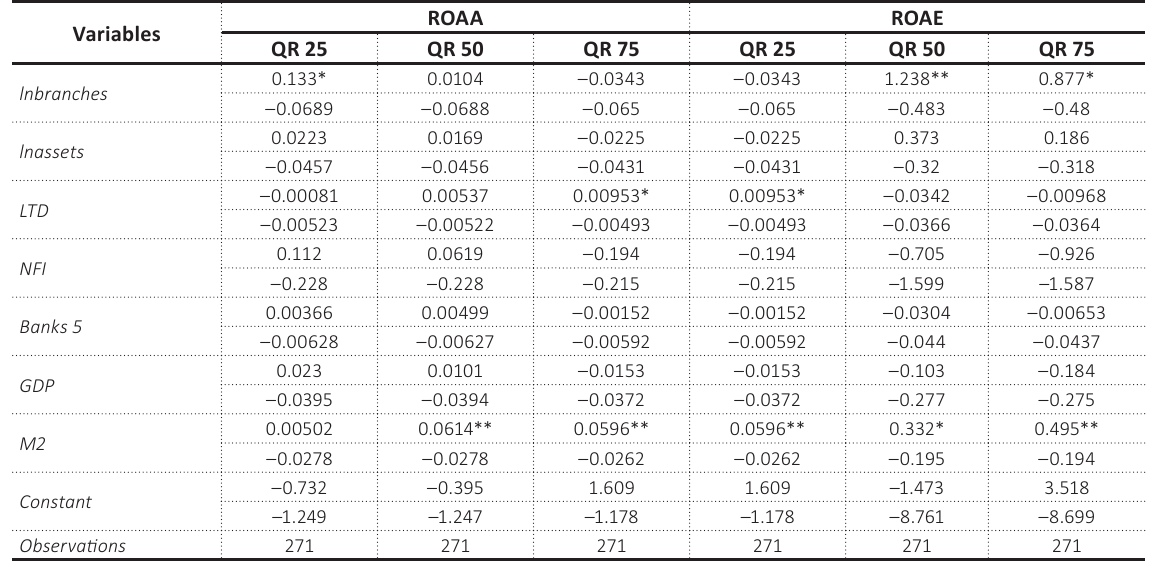
Table 5. Quintile estimation results for